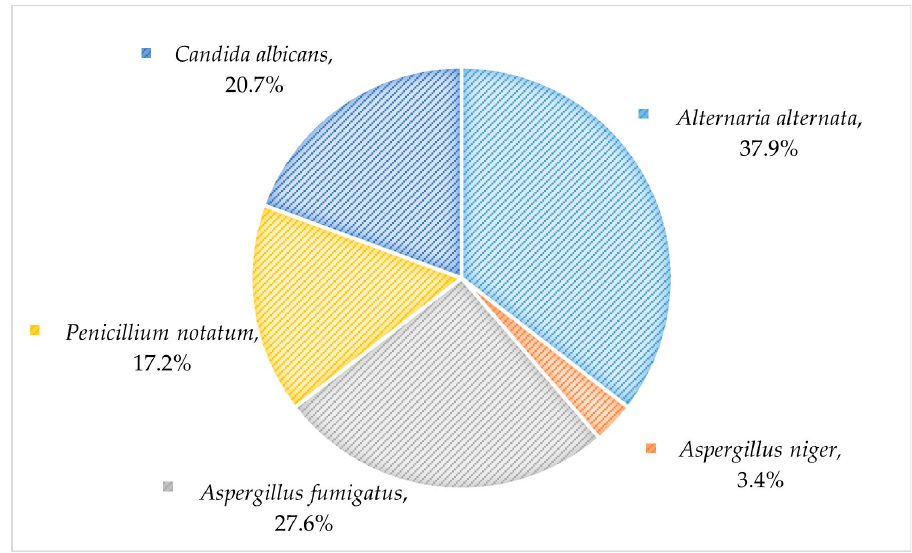
Figure 5. Fungal aeroallergen monosensitization rate in the studied patients by immunoblot assay (n = 29).